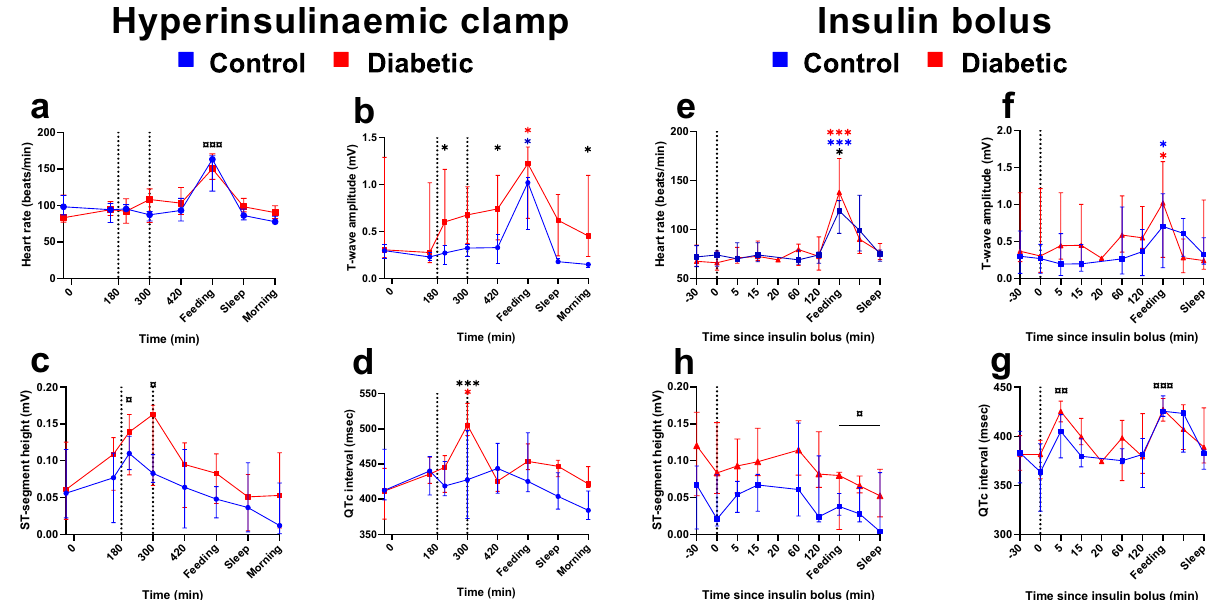
Figure 3. Electrocardiographic morphology. Measures of changing electrocardiographic morphology. Heart rate in beats-per-minute ( a + e ), amplitude of the T-wave in mV ( b + f ), height of the ST-segment in mV ( c + g ) and heart rate corrected duration of the QT-interval ( d + h ) during hyperinsulinaemic clamp and insulin bolus study. Clamp: blue lines: control pigs, red lines: diabetic pigs. Bolus: green lines: control pigs, orange lines: diabetic pigs. Data as medians ± interquartile range. Significant difference to baseline within group is illustrated with accordingly colored stars (*), and, when both groups are considered together, as black currency sign ( ¤) . Significance between groups as black stars (*). * P < .05, ** P < .001, *** P < .0001, by linear mixed modelling. Vertical lines: start and end of hypoglycaemia in the clamp or insulin bolus time. Software used to generate graphs: GraphPad Prism 8 (GraphPad Software Inc., San Diego,